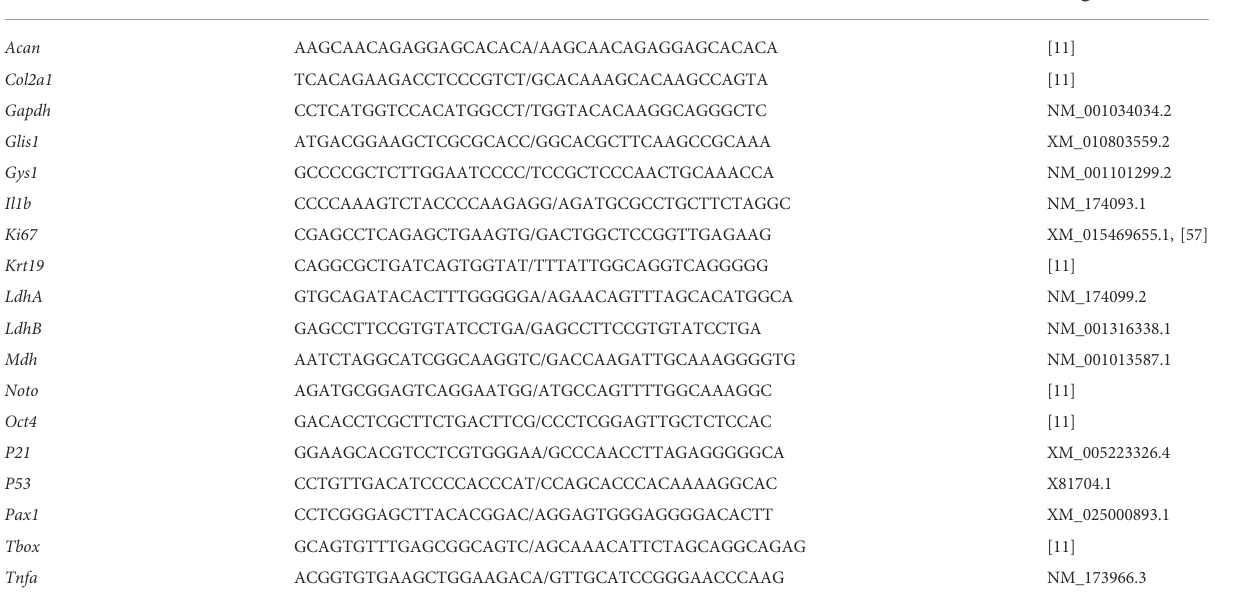
TABLE 2 Primer sequences used to generate RNA in situ hybridization